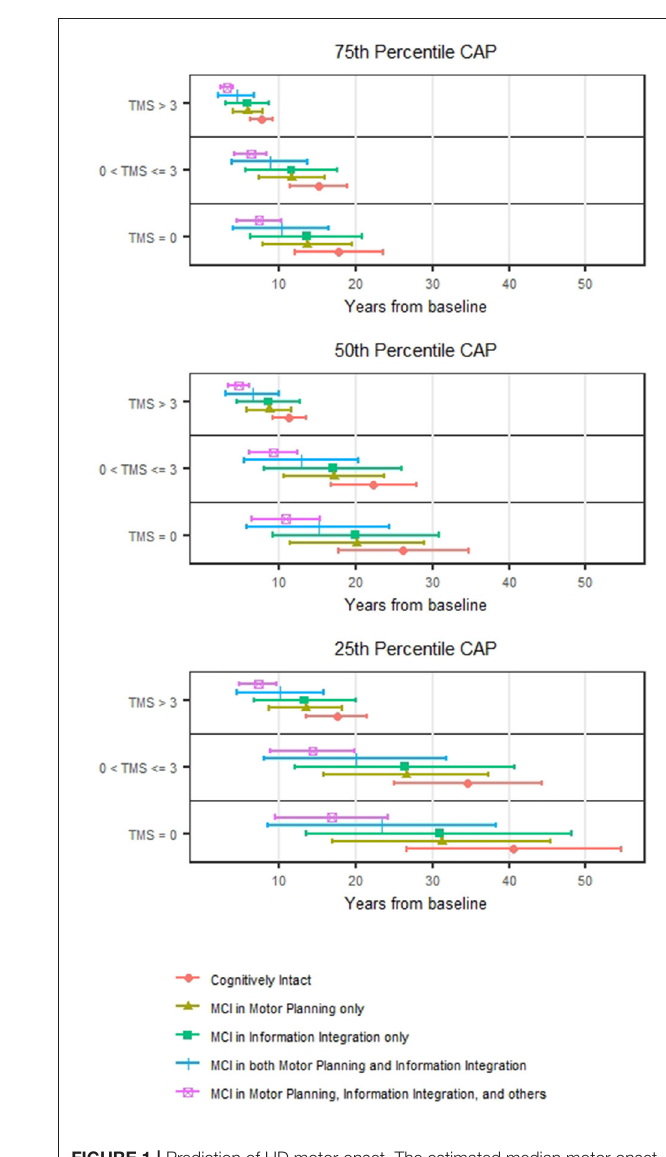
FIGURE 1 | Prediction of HD motor onset. The estimated median motor onset time from the baseline and its 95% confidence interval stratified by TMS (0, > 0–3, and > 3) for individuals with CAP at the 25th, 50th, and 75th